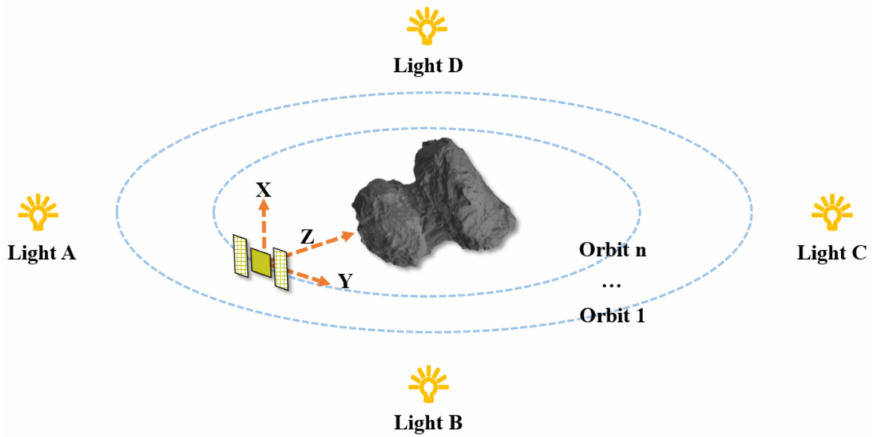
Figure 7. Schematic Diagram of Simulation Image Generation.